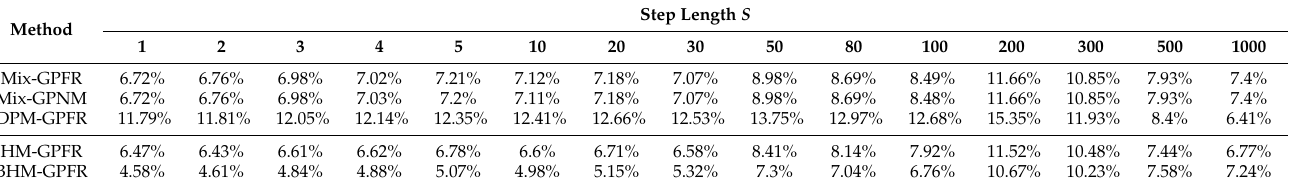
Table 2. MAPE of GP-related methods under the cold start setting ( r =